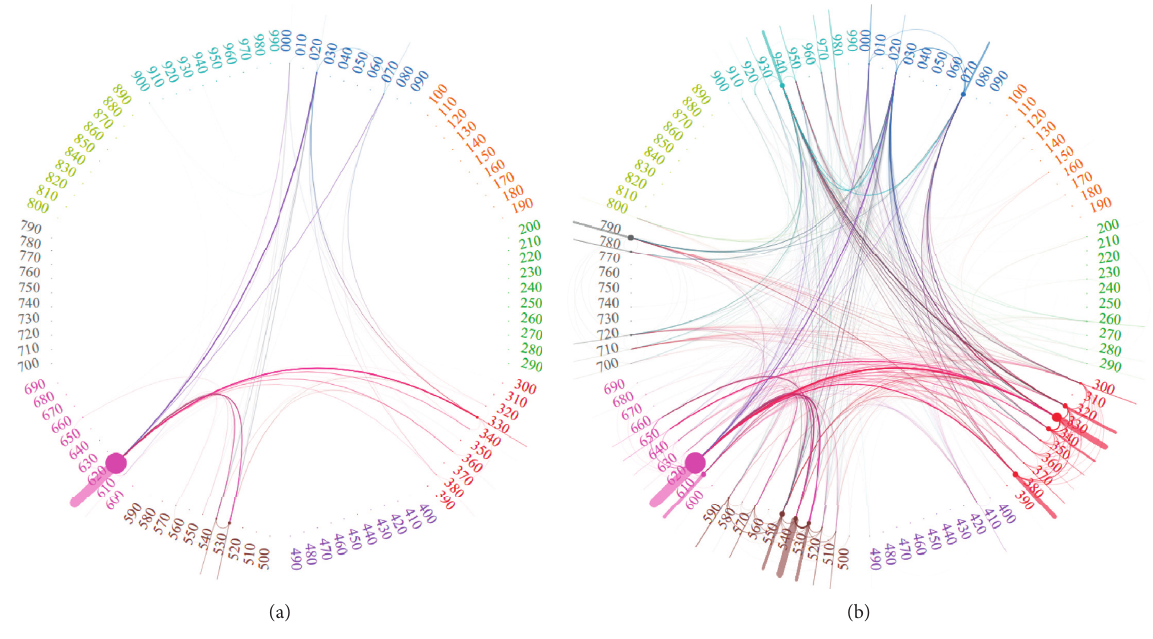
Figure 7: Visualization (by means of PolyViz [73]) of the TTN of the 1 st orbit (a) and of the 2 nd orbit (b) of the German Wikipedia article Kernkraftwerk ( Nuclear power plant ). The TTNs are derived from the corpora of articles in the 1 st and 2 nd orbits (see formula (30)) of this article. Obviously, the most prominent 2 nd level DDC class in both TTNs is 620 ( Engineering ). Compared to the example in Figure 6, the 2 nd orbit is now thematically much more